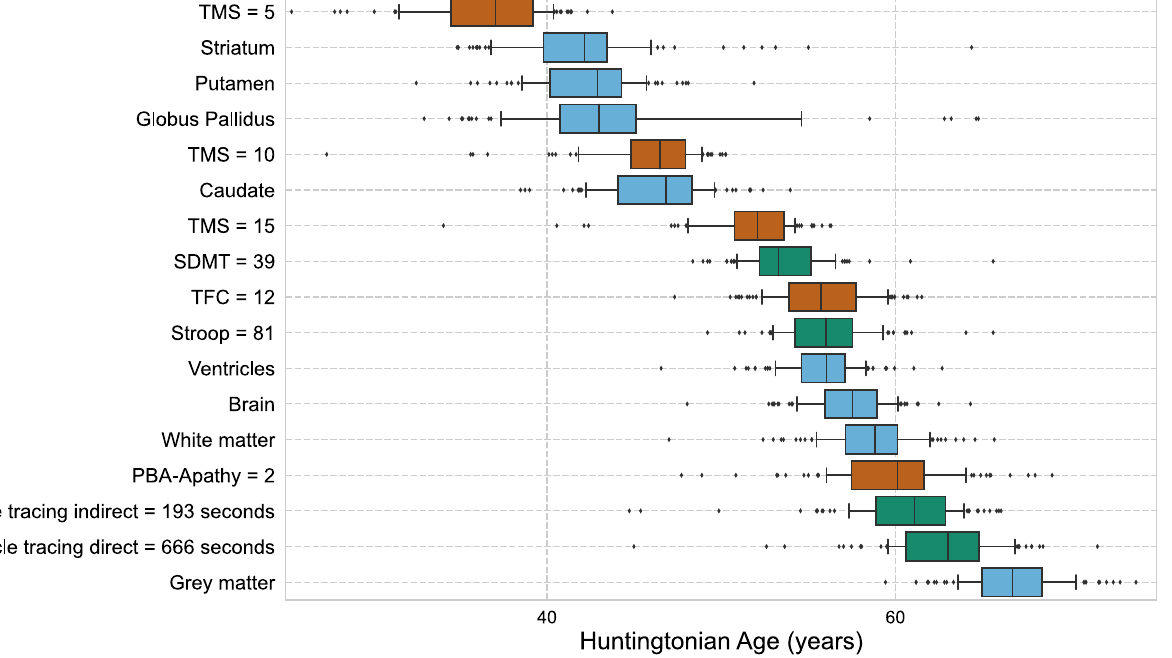
Figure 4. Huntington disease shows a specific temporal ordering of biomarker changes. We repeatedly calculated the age at which each biomarker diverged from control values. The central line is the median age of 100 simulations. The boxplots show the first and third quartiles, and the whiskers show the first and ninth decile. For instance, motor changes (TMS = 5) are the first detectable sign of HD at HA of 37 years, with an interquartile confidence interval from 34.5 to 39.2